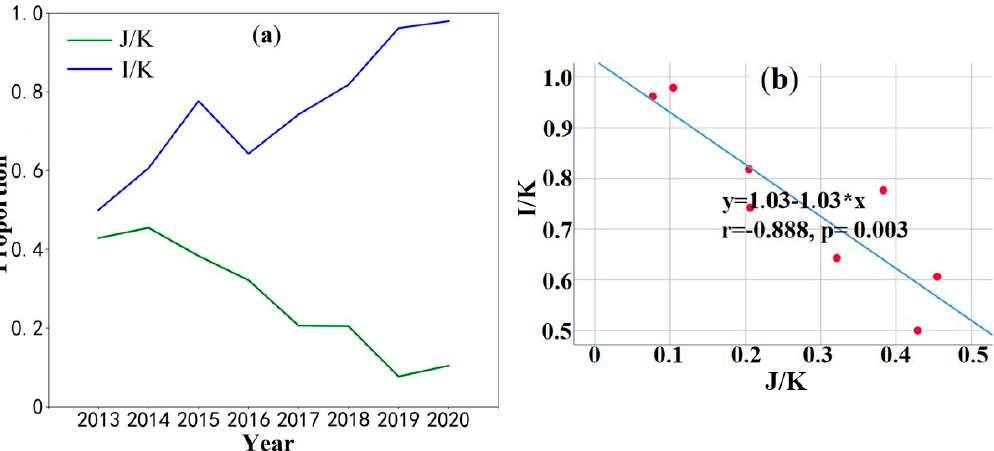
Figure 7. Annual change in the proportion of forest fires detected by VIIRS and the proportion of lightning-caused forest fires in the jurisdiction of Heilongjiang Province from 2013 to 2020 ( a ) and linear correlation analysis between the two ( b ), where K is the total number of historical forest fires, I is the number of historical forest fires caused by lightning, and J is the number of historical forest fires detected by VIIRS.